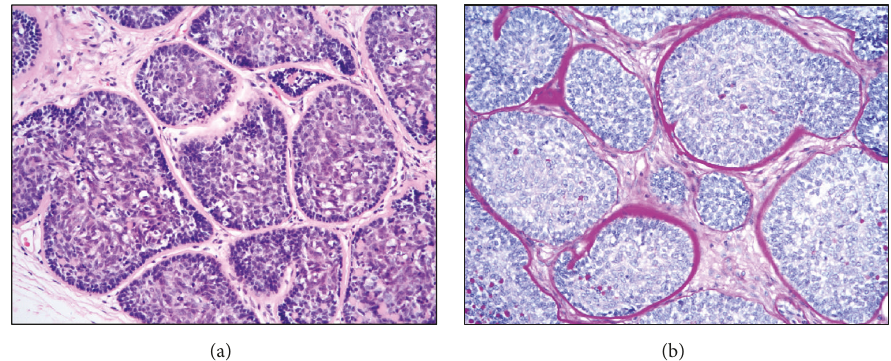
Figure 3: Histopathologic findings: (a) intermediate magnification of “jigsaw pattern” with biphasic cell nests showing outer somewhat palisaded small blue cells and central basaloid cells with slightly more abundant eosinophilic cytoplasm as well as fibrous stroma, H&E stain, 200x; (b) basement membrane material investing periphery of epithelial nests, PAS stain,